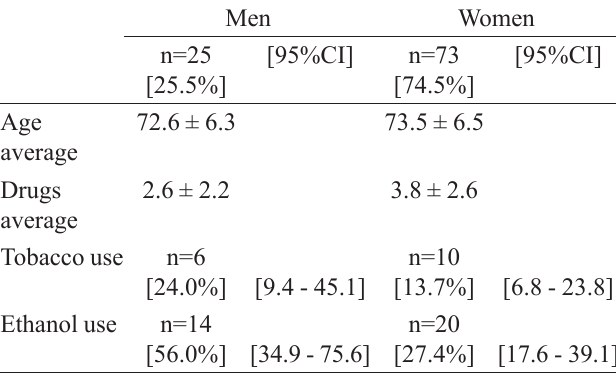
TABLE I - Characteristics of the elderly population using CNS acting drugs (n=98)